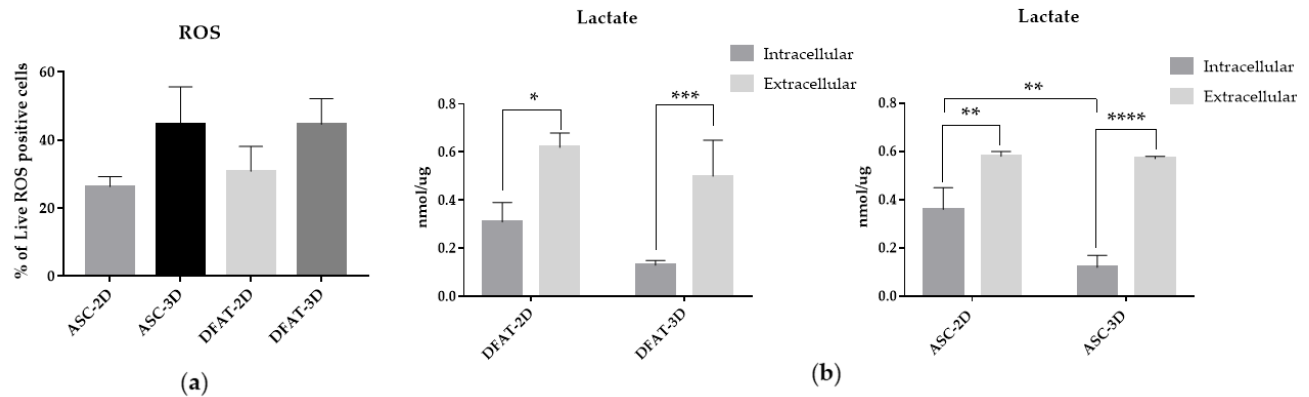
Figure 9. ( a ) The intracellular Reactive Oxygen Species (ROS) accumulation in live cells. ( b ) The intracellular and extracellular lactate production. The results are presented as mean values of 3-4 experiments ± SD and normalized per µg of protein, for * p < 0.05, ** p <0.01, *** p < 0.001, **** p < 0.0001.